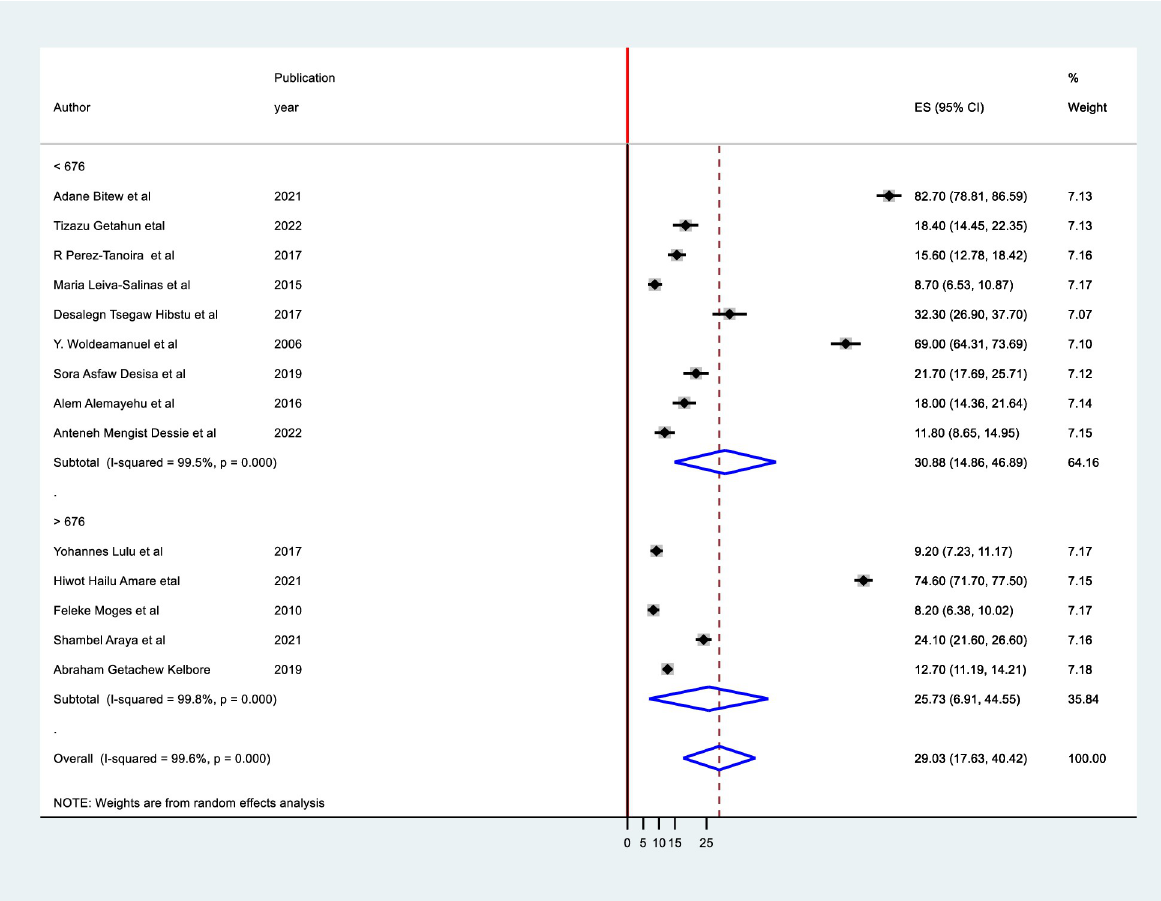
Fig 6. Funnel plot of tinea capitis to check publication bias.